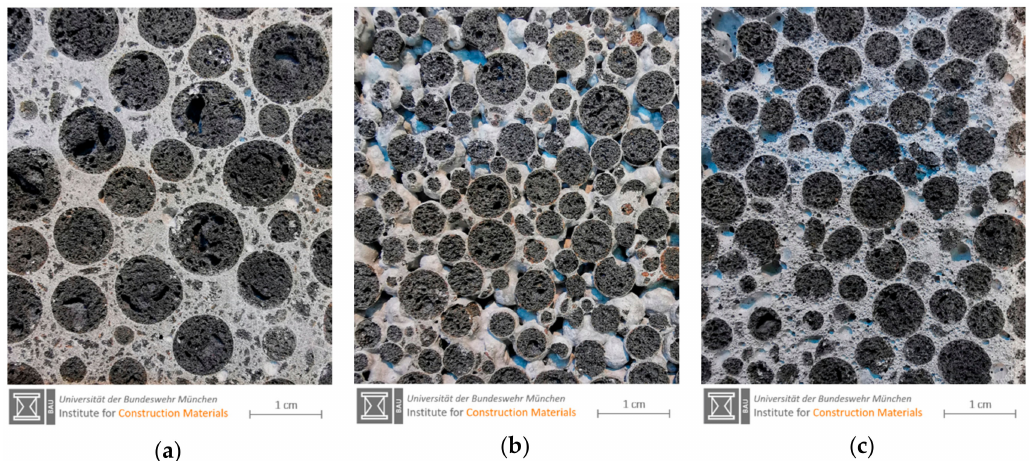
Figure 2. ( a ) Image of structural lightweight concrete (LC) with a dense matrix structure; ( b ) Image of the lightweight aggregate concrete (LAC) with open pore structure; ( c ) Image of LAC with a porous matrix filling the open pore structure. All three types of lightweight concrete are based on expanded clay from one producer as